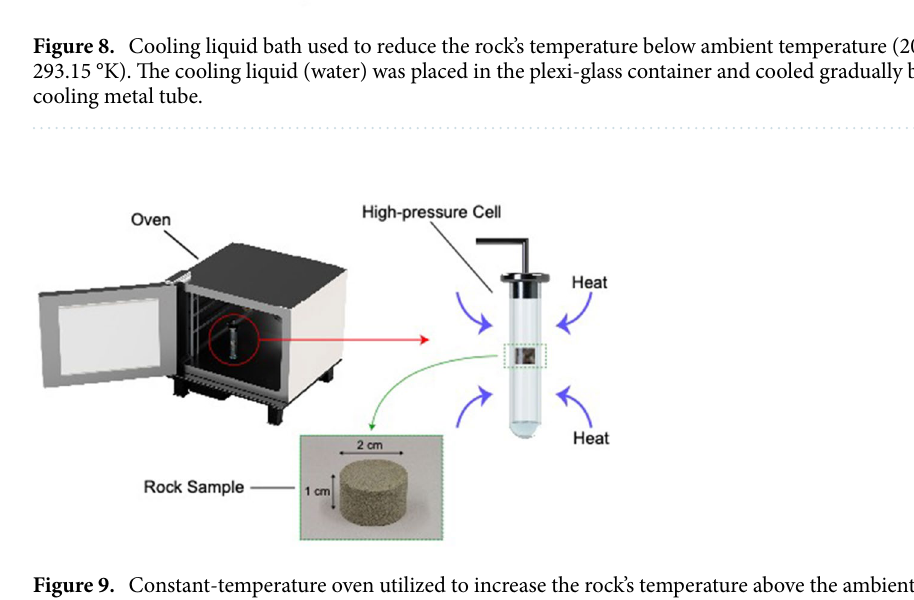
Figure 9. Constant-temperature oven utilized to increase the rock’s temperature above the ambient temperature. The oven ensured a uniform heat migration to the system and a homogeneous temperature distribution around the